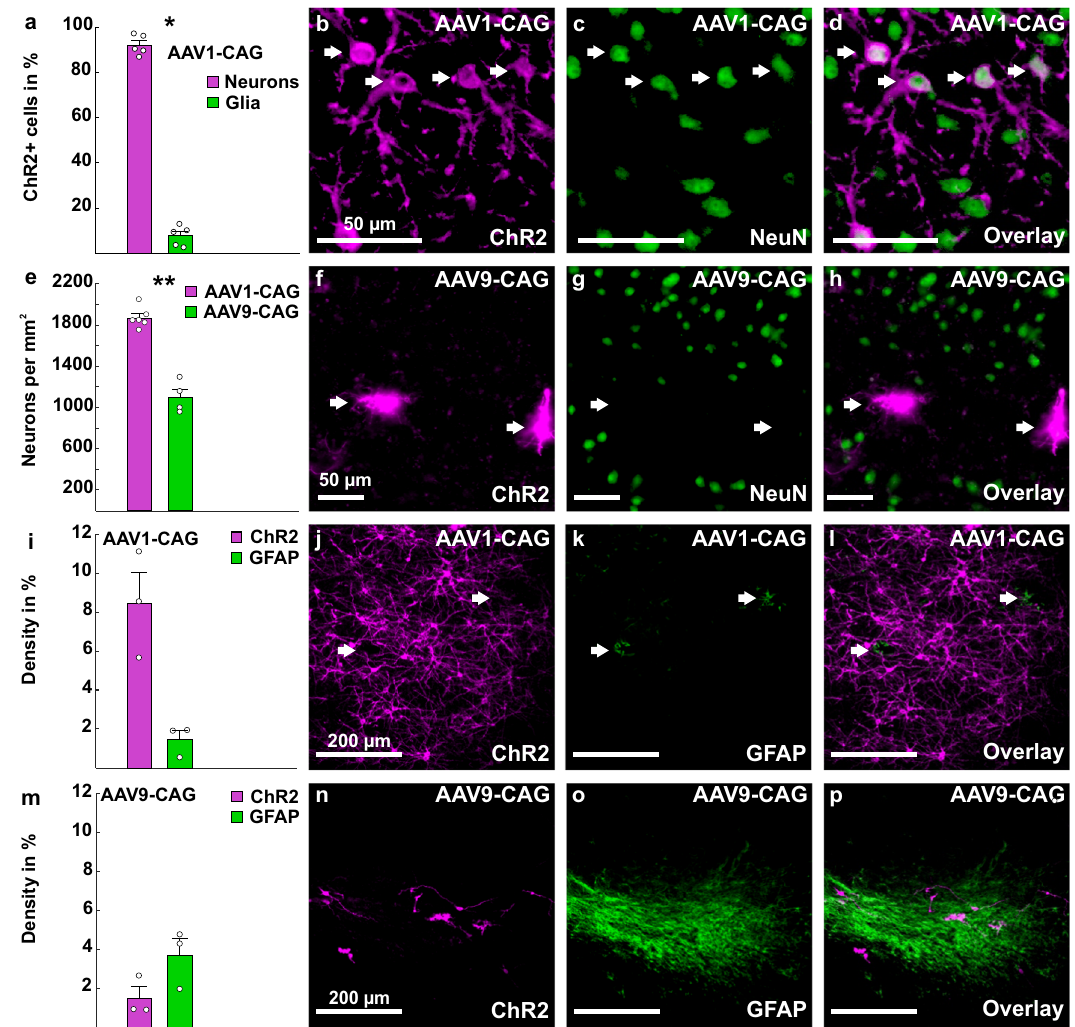
Fig. 4 Cellular tropism of AAV1-CAG and AAV9-CAG. a – d AAV1-CAG-ChR2 leads to ChR2 expression in signi fi cantly more neurons (pink bar) than glial cells (green bar, n = 5 injections). b ChR2 expression after injections of AAV1-CAG. c NeuN expression in the corresponding injection site. d Overlay of ChR2 and NeuN expression. e – h AAV9-CAG (green bar, n = 4 injections) leads to a signi fi cant reduction of NeuN in the injection site compared to AAV1- CAG (pink bar, n = 5 injections). f ChR2 expression following injections of AAV9-CAG. g NeuN in the corresponding injection site. h Overlay of ChR2 and NeuN expression indicating that AAV9-CAG injections result in reduced NeuN expression in the injection site. i – l AAV1-CAG leads to extensive ChR2 expression (pink bar), but only to weak GFAP expression (green bar, n = 3 injections). j ChR2 expression following injections of AAV1-CAG-ChR2. k